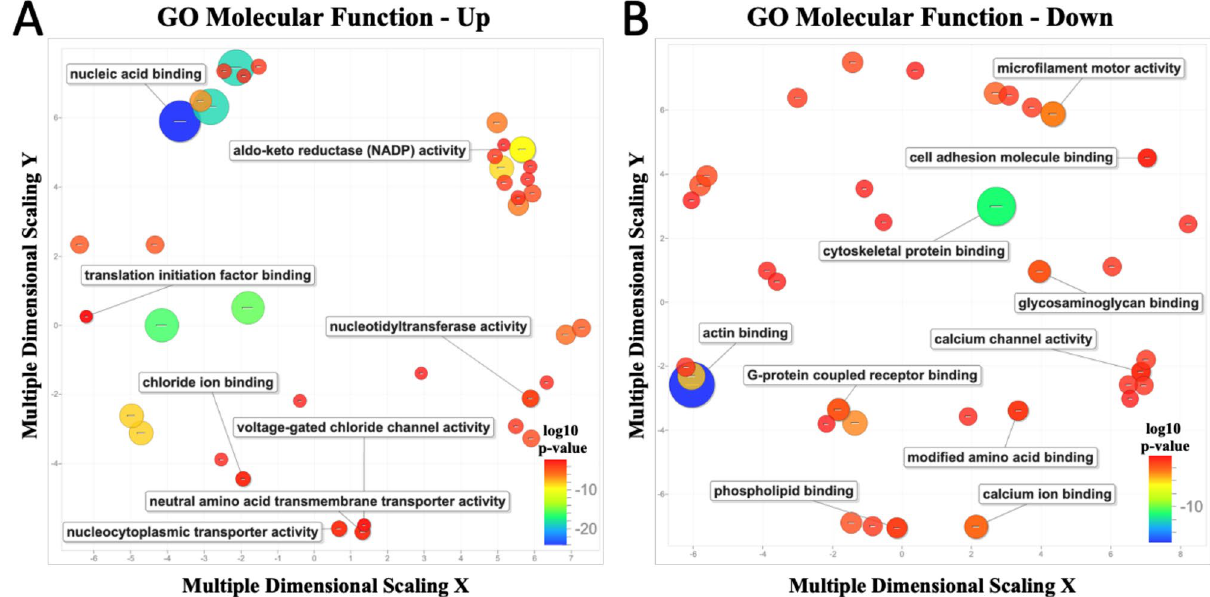
Figure 3. GO enrichment analyses of FSS treated and static controls. Scatterplot of enriched pathways for a subset of up-regulated genes ( A ) and down-regulated ( B ). To identify similar GO terms among the enriched terms, these were categorized using semantic clustering (REVIGO). The GO terms within the scatterplot are represented as a circle and are related to each other and to a similar process. The circle size symbolizes